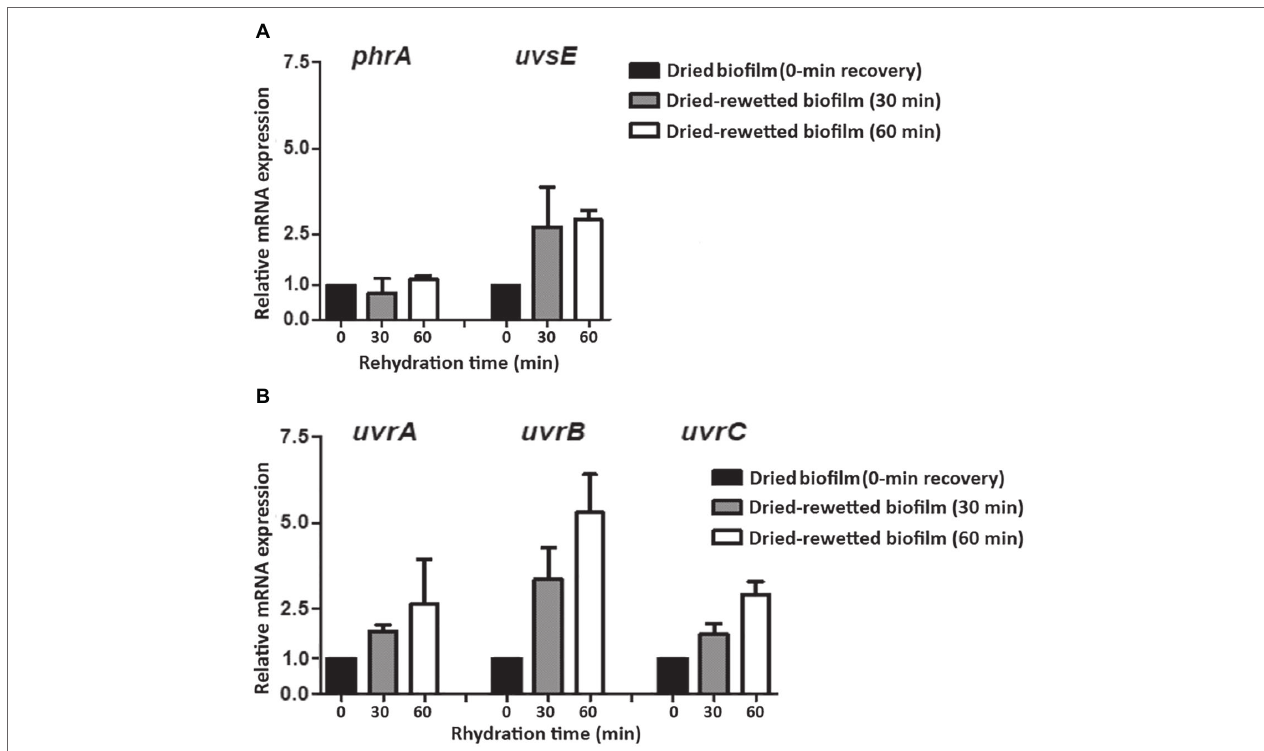
FIGURE 5 | Expression of DNA repair genes in dried-rewetted biofilm after 30 and 60 min of rehydration. Expression of the phrA and uvsE genes (A) and of uvrA, uvrB , and uvrC genes (B) . Values from dried biofilms (0-min rewetting) were considered as control values set to 1. Subsequent samples were compared in terms of fold regulation to control values.